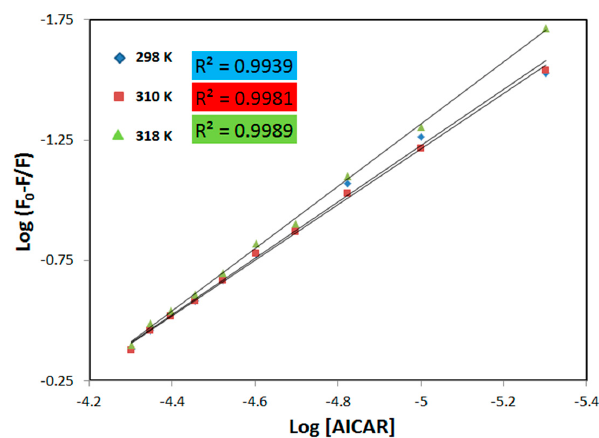
Figure 2. The plot of log [( F 0 − F )/ F ] versus log[Q] for HSA in the presence of AICAR at three different temperatures. Fixed [HSA] = 5 μ M, increasing concentration of [AICAR] = 5–50 μ M, pH = 7.4, in 10x-PBS buffer. Table 2. Thermodynamic binding parameters of the AICAR–HSA complex.